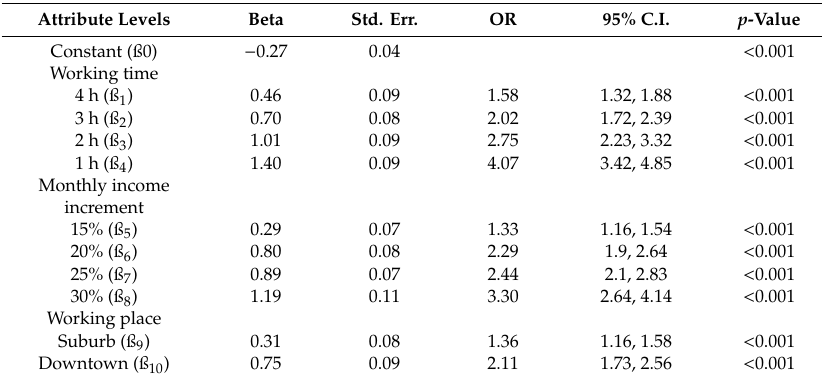
Table 4. Main e ff ects model results.